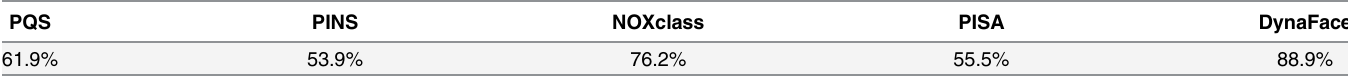
Table 3. The success rate of PQS, PINS, NOXclass, PISA and DynaFace in the detection of the crystal packing interfaces of S7 Table.